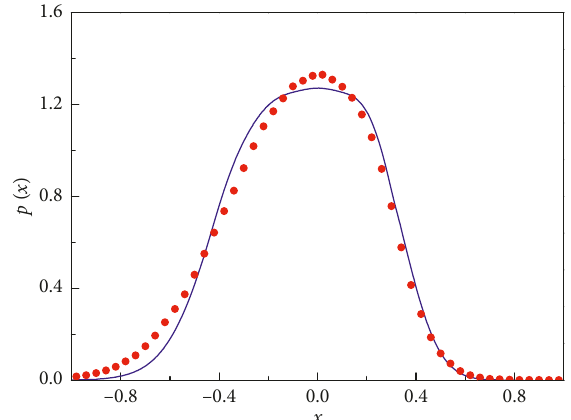
Figure 6: The marginal probability densities of system responses ( α � 0 . 5) (solid line: the proposed results; discrete symbols: Monte Carlo simulation results).